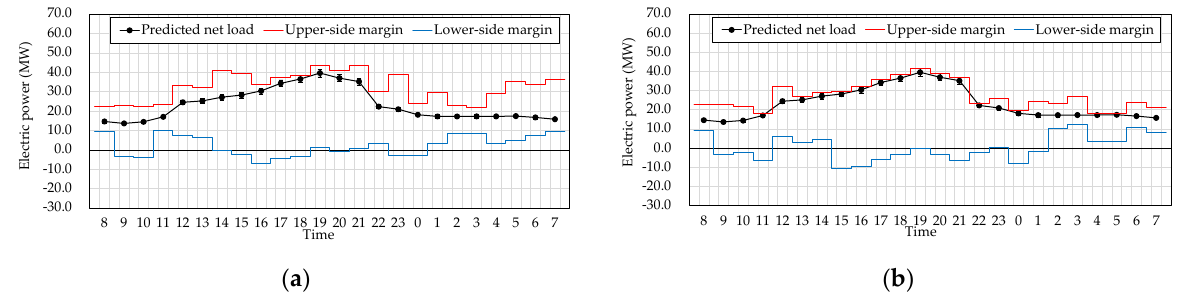
Figure 7. Comparison of operational margins: ( a ) Proposed framework; ( b ) Traditional framework.